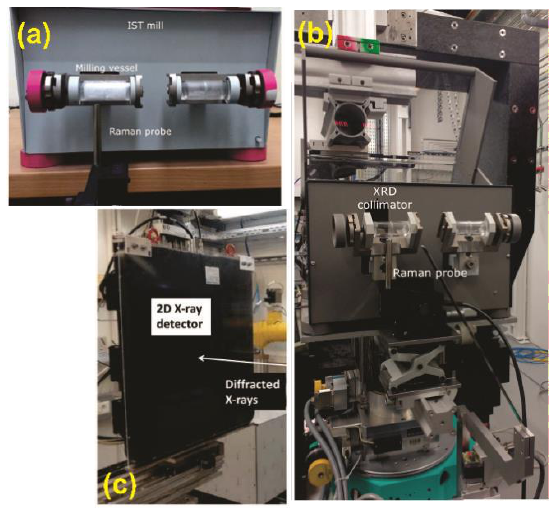
Figure 7. ( a ) An InSolido Tech (Zagreb, Croatia) vibratory ball mill with transparent milling vessels (typically made of PMMA) and an optical fiber Raman probe and detector focused on the bottom of a reaction jar for in situ reaction monitoring using Raman spectroscopy. ( b ) In situ kinetics monitoring with synchrotron X-ray powder diffraction and Raman spectroscopy can also be carried out simultaneously. In addition to the Raman probe (as in ( a )), the figure shows the location of a beam collimator for the X-ray synchrotron beam in an InSolido Tech (Zagreb, Croatia) ball mill. Figure reproduced from reference [9] with permission. ( c ) An area detector for X-rays is used for the fast measurement of Debye rings of diffracted radiation, which are then converted to X-ray powder diffraction patterns for quantitative phase analysis. Figure reproduced from reference [36] with permission from John Wiley and Sons obtained through Copyright Clearance Center.